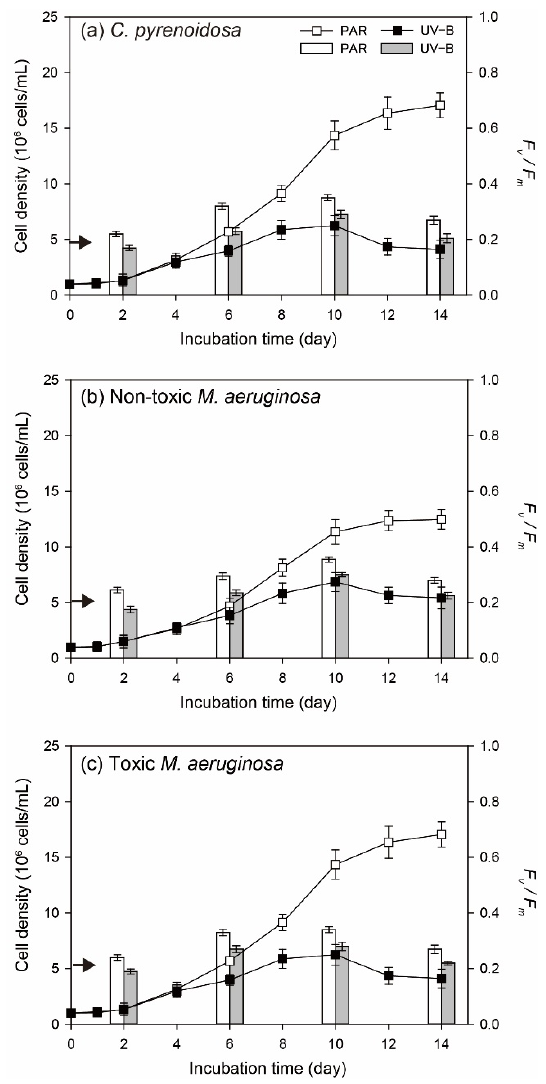
Figure 1. Cell density (line and scatter) and F v /F m (vertical bar) of three species in the PAR and UV ‐ B treatments under normal growth conditions (the arrow indicates the initial value of F v /F m ).